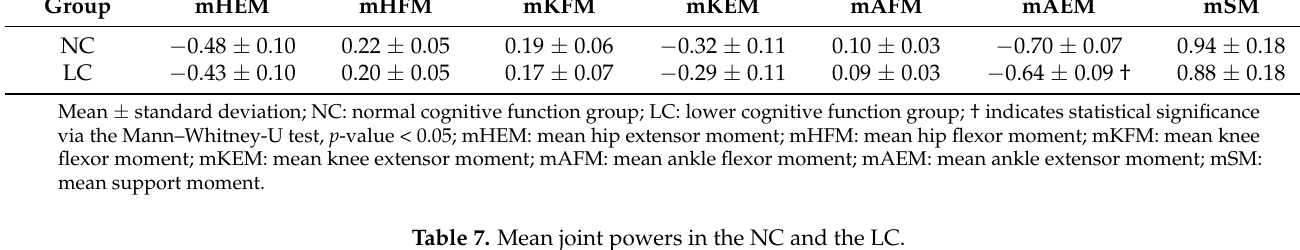
Table 7. Mean joint powers in the NC and the